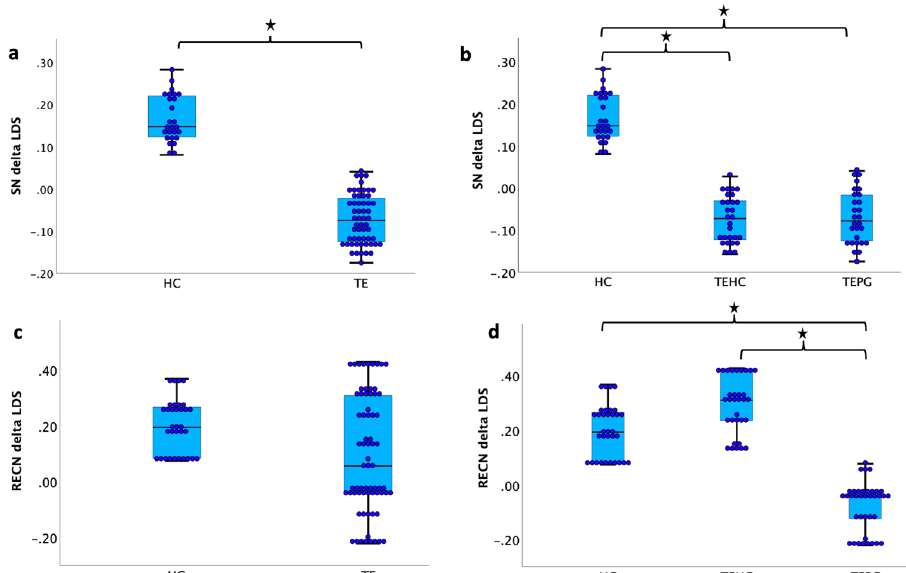
Fig. 3 Neural activity changes measured by Linear deviation scores (LDS). a LDS changes for SN in TE and HC groups. b LDS changes for SN in TEPG, TEHC and HC groups. c LDS changes for RECN in TE and HC groups. d LDS changes for RECN in TEPG, TEHC and HC groups. n = 83, error bar stand for ±2 standard error (SE). LDS linear deviation scores, SN salience network RECN right executive control network, HC non-trauma-exposed healthy controls, TEHC trauma-exposed healthy controls, TEPG trauma-exposed psychopathology